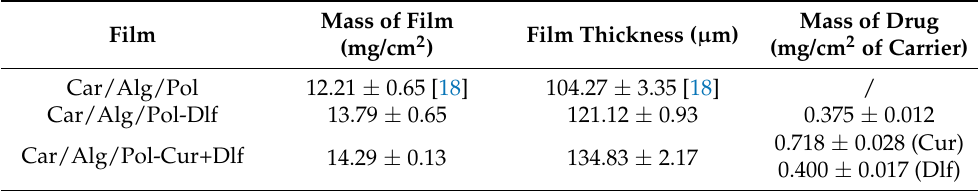
Table 1. Basic film characteristics ( n = 5).